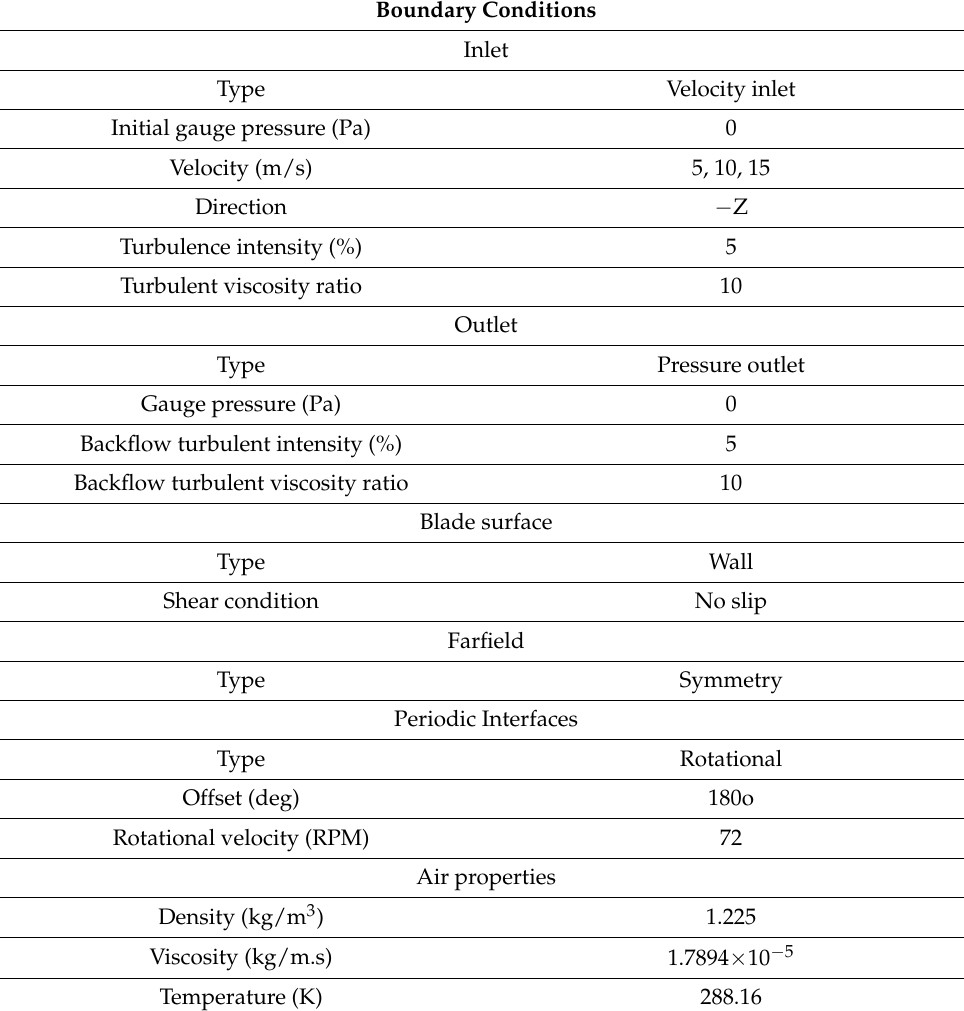
Table 2. Boundary conditions and fluid